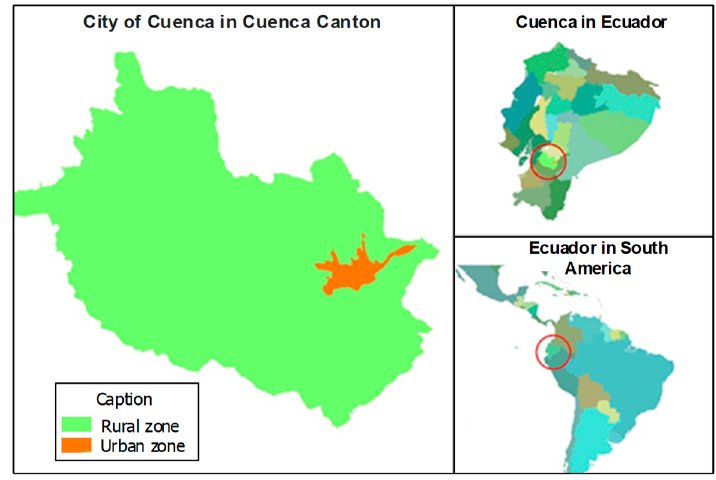
Figure 1. The geographic location of Cuenca Canton, urban area. Source: Based on information from INEC [35] and Jaramillo [36].